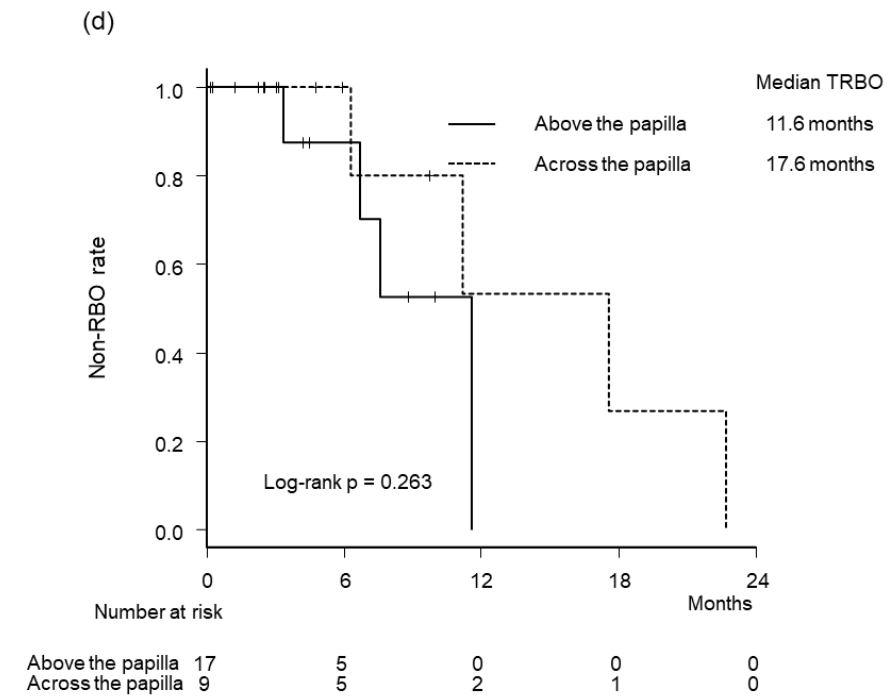
Figure 4. Kaplan–Meier curves by stenting method and primary disease type. ( a ) Overall survival in patients with pancreatic cancer. ( b ) Time to recurrent biliary obstruction in patients with pancreatic cancer. ( c ) Overall survival in patients with non-pancreatic cancer. ( d ) Time to recurrent biliary obstruction in patients with non-pancreatic cancer.